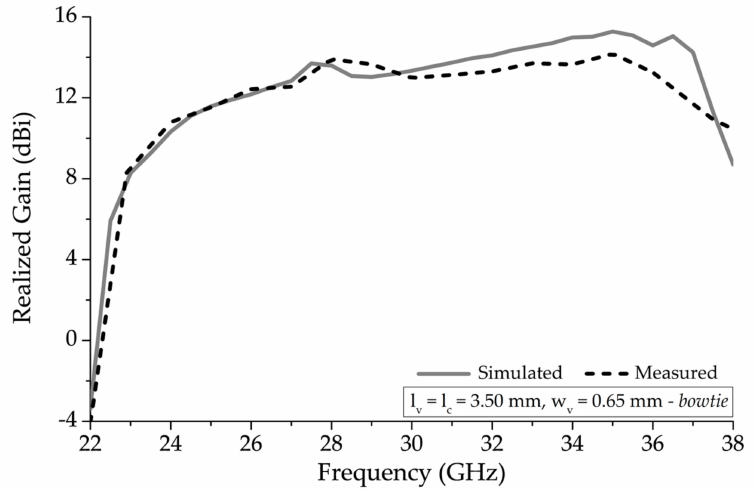
Figure 9. Simulated and measured realized gain comparison of a 13 unit-cell element periodic structure with w v = 0.76 mm and a modified bowtie vertical unit-cell